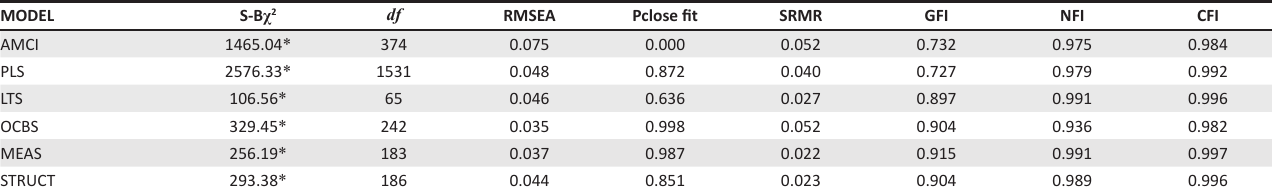
TABLE 3: Goodness-of-fit indices.